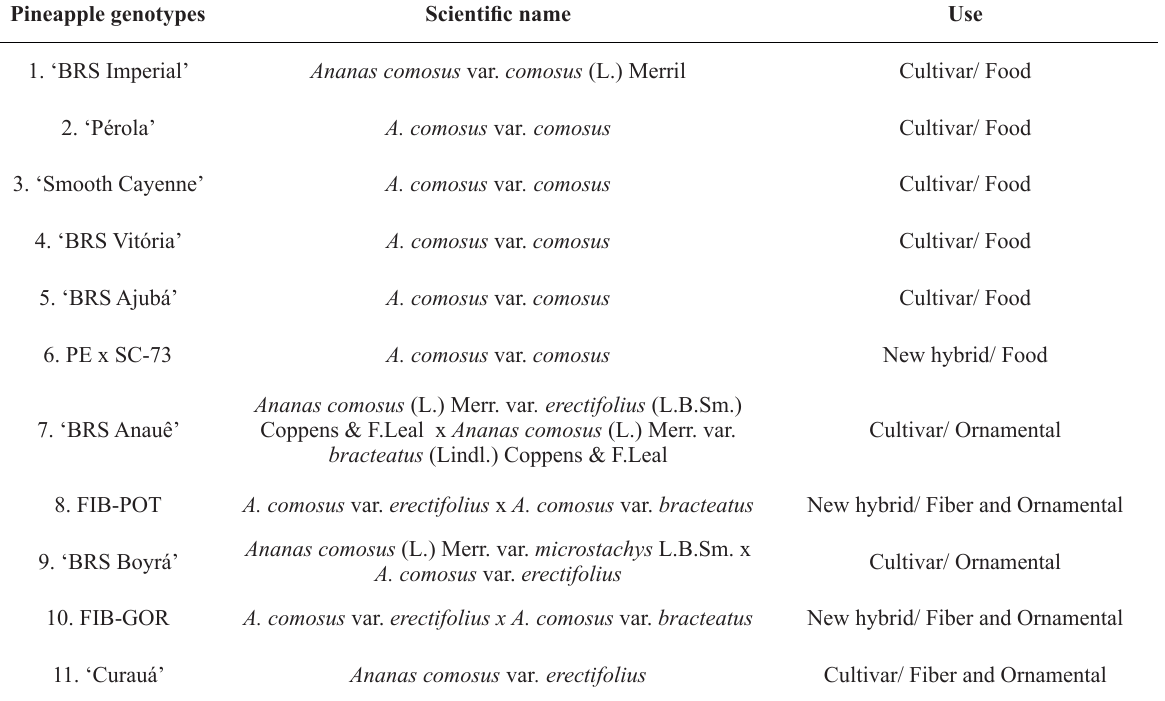
Genotypes evaluated for fiber quality for the use as reinforcement in cement composites. Pineapple